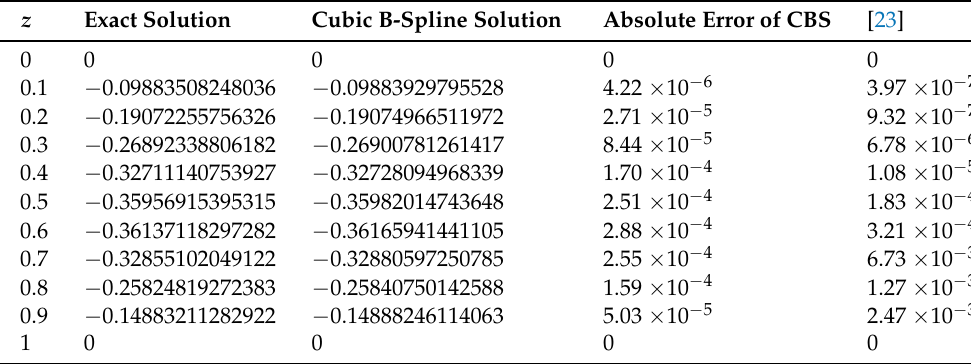
Table 9. Comparison of exact solution and Cubic B-spline solution of Problem 3 at h = 1